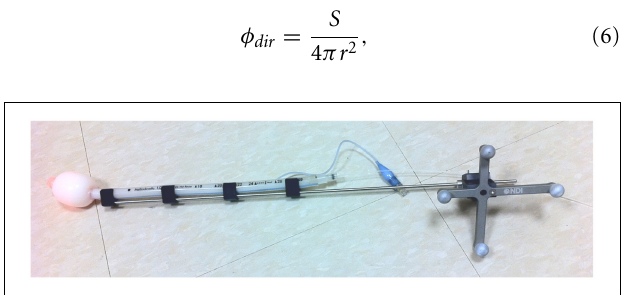
FIGURE 4 | A treatment wand for pleural PDT with an optical fiber and a light diffuser. The treatment wand was attached to the tracking rigid body.